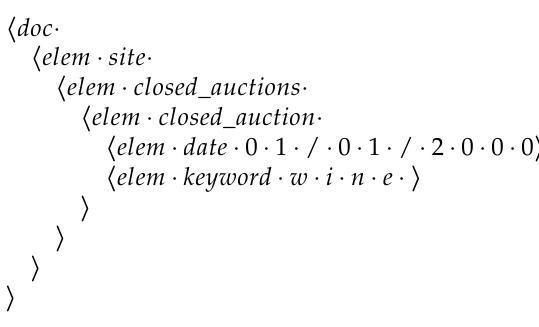
Figure 2. An X ML document.